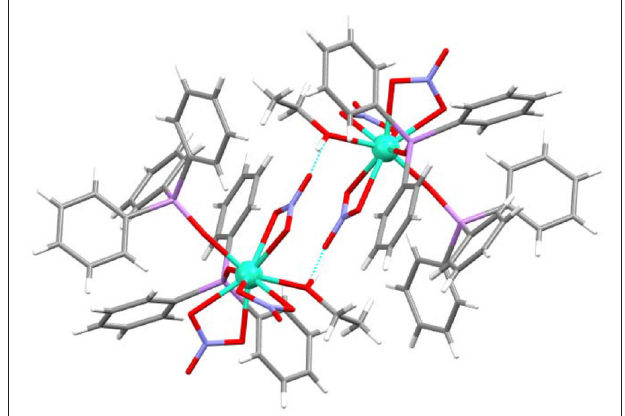
FIGURE 5 | Hydrogen bond for 4 , showing the pseudodimer.